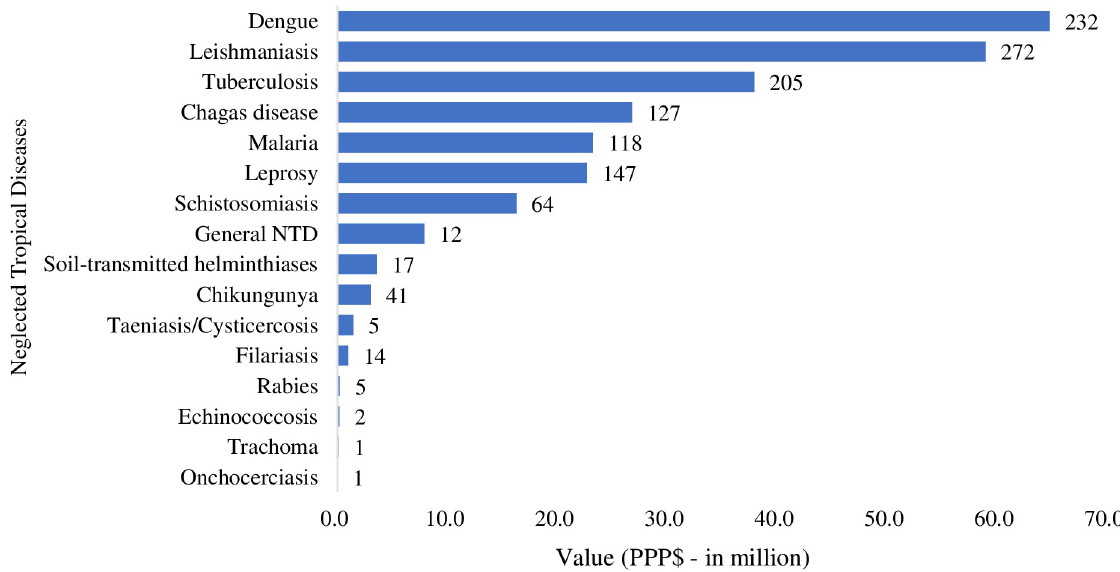
Fig 3. Distribution of research on neglected tropical diseases and the amount invested for each disease. Brazil, 2004 to 2020. PPP$— Purchasing Power Parity–reference year 2021 (amount in million); General NTD–Research that encompassed neglected tropical diseases in general, without specifying the disease. Note 1: The number at the top of the bars corresponds to the total number of studies on neglected tropical disease by type of disease. Note 2: 105 surveys encompassed more than one neglected tropical disease and were therefore counted more than once. Thus, the number (1,263 studies) and the amount financed (PPP$ 268.6 million) stratified by type of disease is greater than the number of studies (1,158) and amount funded (PPP$ 230.9 million). Source: based on data obtained from the Health Research repository [29], accessed in June